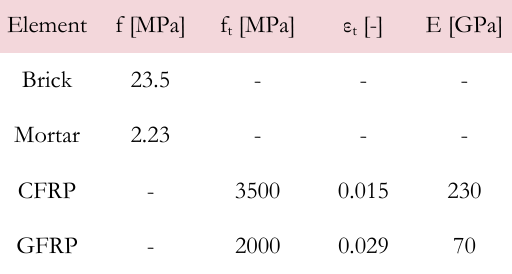
Table 7.A: Mechanical properties of constituents for the experimental tests [39].